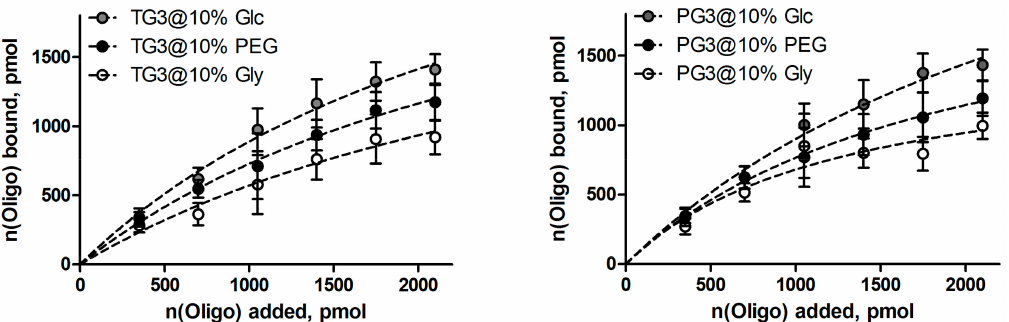
Figure 5. Profiles of the oligonucleotide binding by TG3 and PG3 dendrimer-based hydrogels.